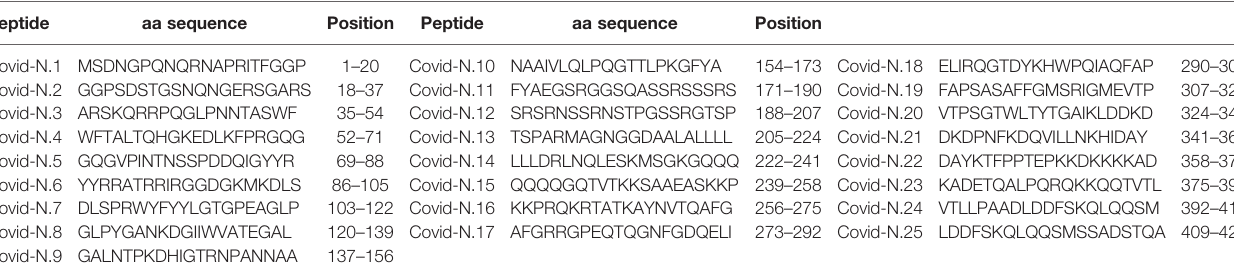
TABLE 1 | Sequence and position of SARS-CoV-2 S and N protein peptides. Peptide aa